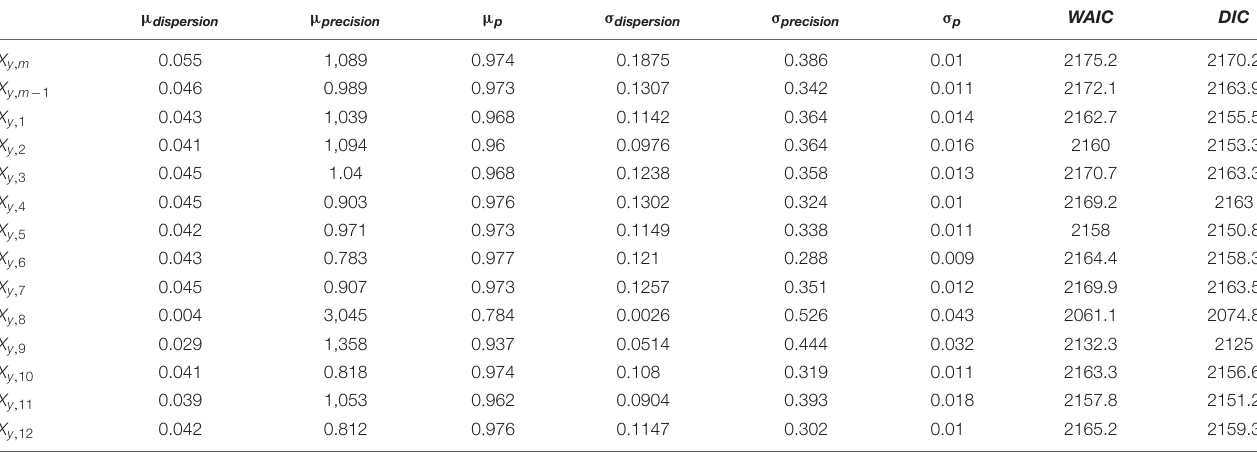
TABLE 1 | Estimates and performance of models with different explanatory variables for the sighting